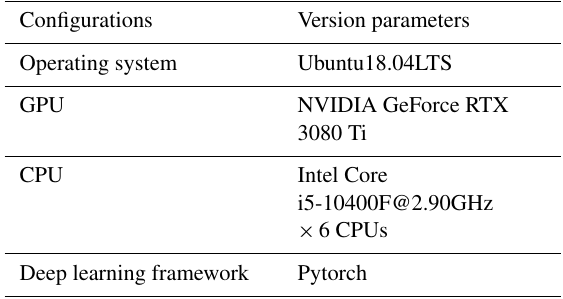
Table 1. Software and hardware